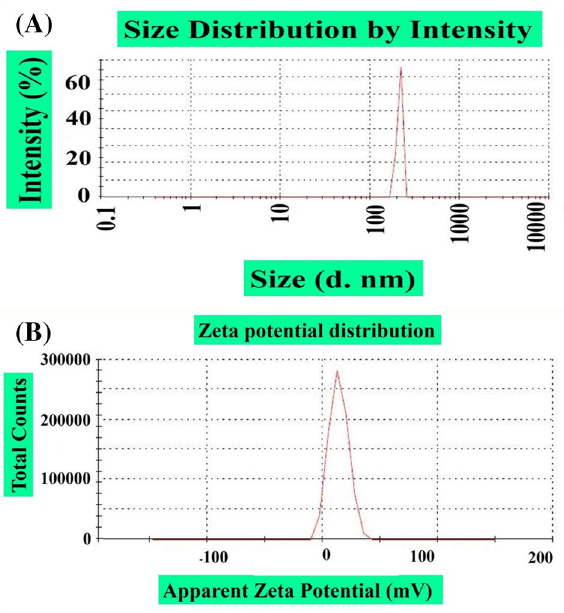
Figure 2. ( a ) Size distribution of greenly formulated ZnONPs ( b ) Zeta potential of greenly formulated ZnONPs.